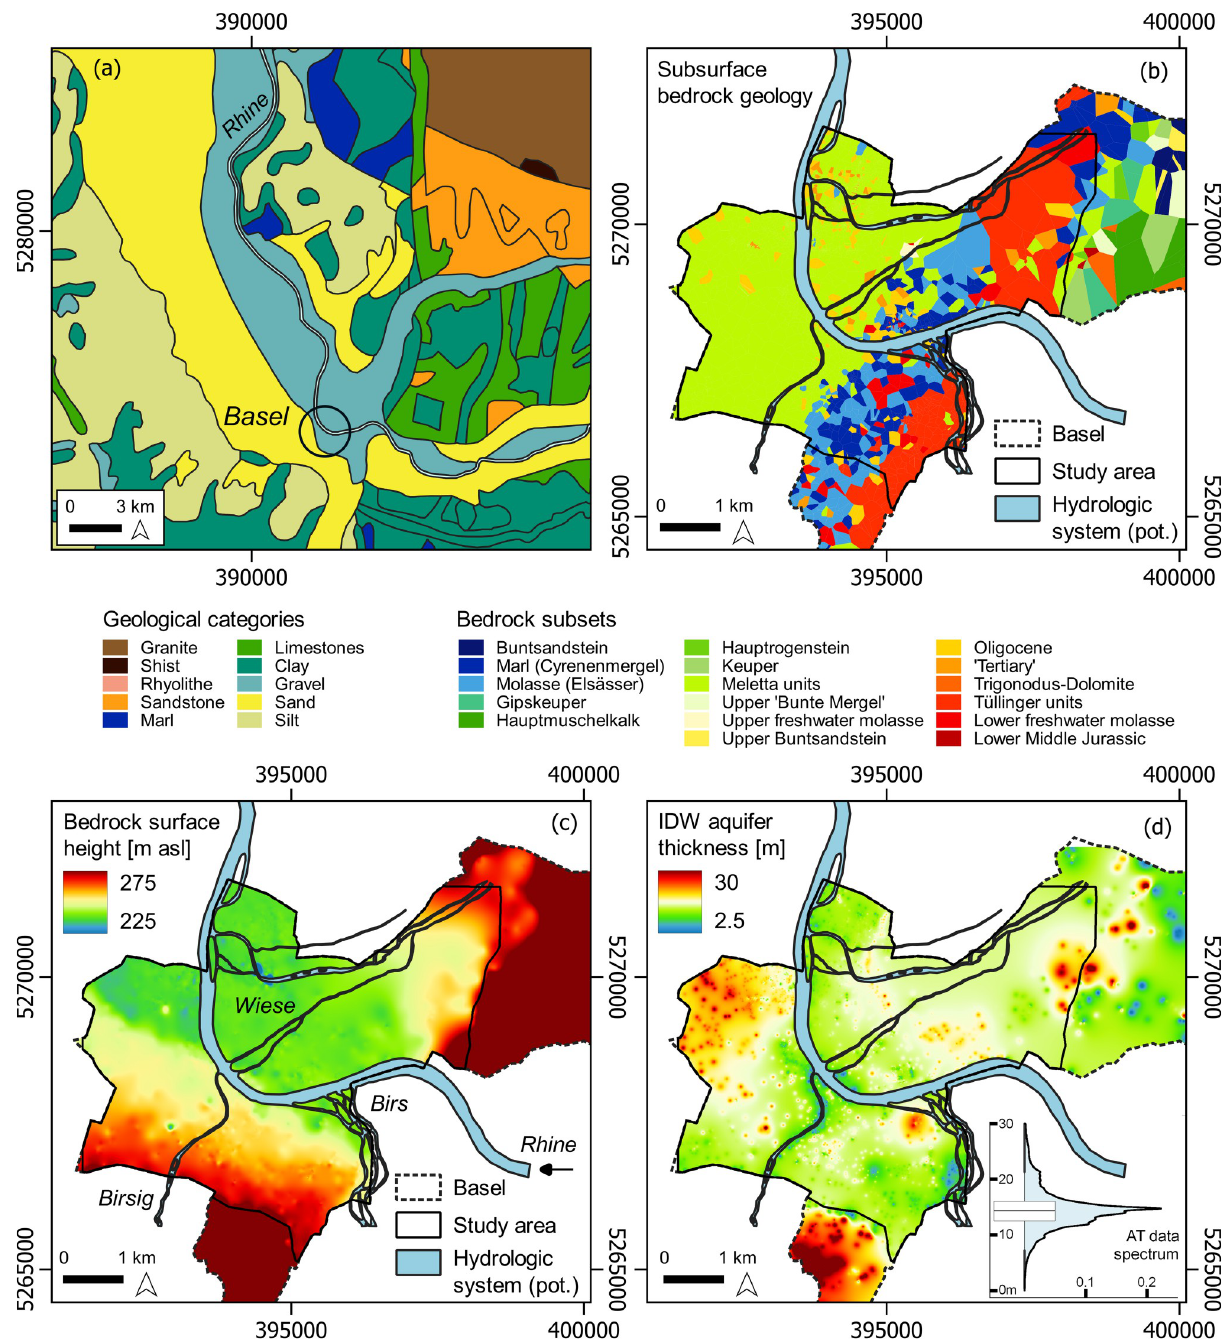
Fig 3. Geological and hydrogeological conditions in the study area at Basel. (a) regional, large-scale geological near-surface units; (b) locally estimated geological coring samples visualized as Voronoi polygons of the underlying bedrock surface (covered by Holocene gravel deposits); (c) multilevel b-spline interpolation of the underlying bedrock surface absolute height; (d) IDW interpolated aquifer thickness (Holocene gravel deposits) at Basel based on absolute coring height samples; boxplot and density curve of the data frequency. Images are for illustrative purpose only. Data source Fig 3 (a): geological map of Germany derived from INSPIRE under Creative Commons Attribution 4.0 International (CC BY 4.0) licence (https://download. bgr.de/bgr/Geologie/GK1000-INSPIRE/gml/GK1000-INSPIRE.zip, last accessed 3 rd of November 2022).